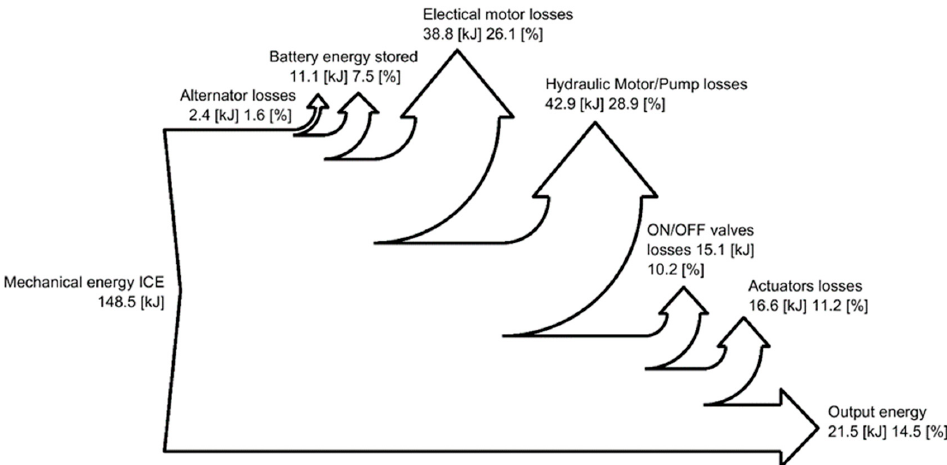
Figure 16. Sankey diagram for the digging duty cycle—DDH without pipes.